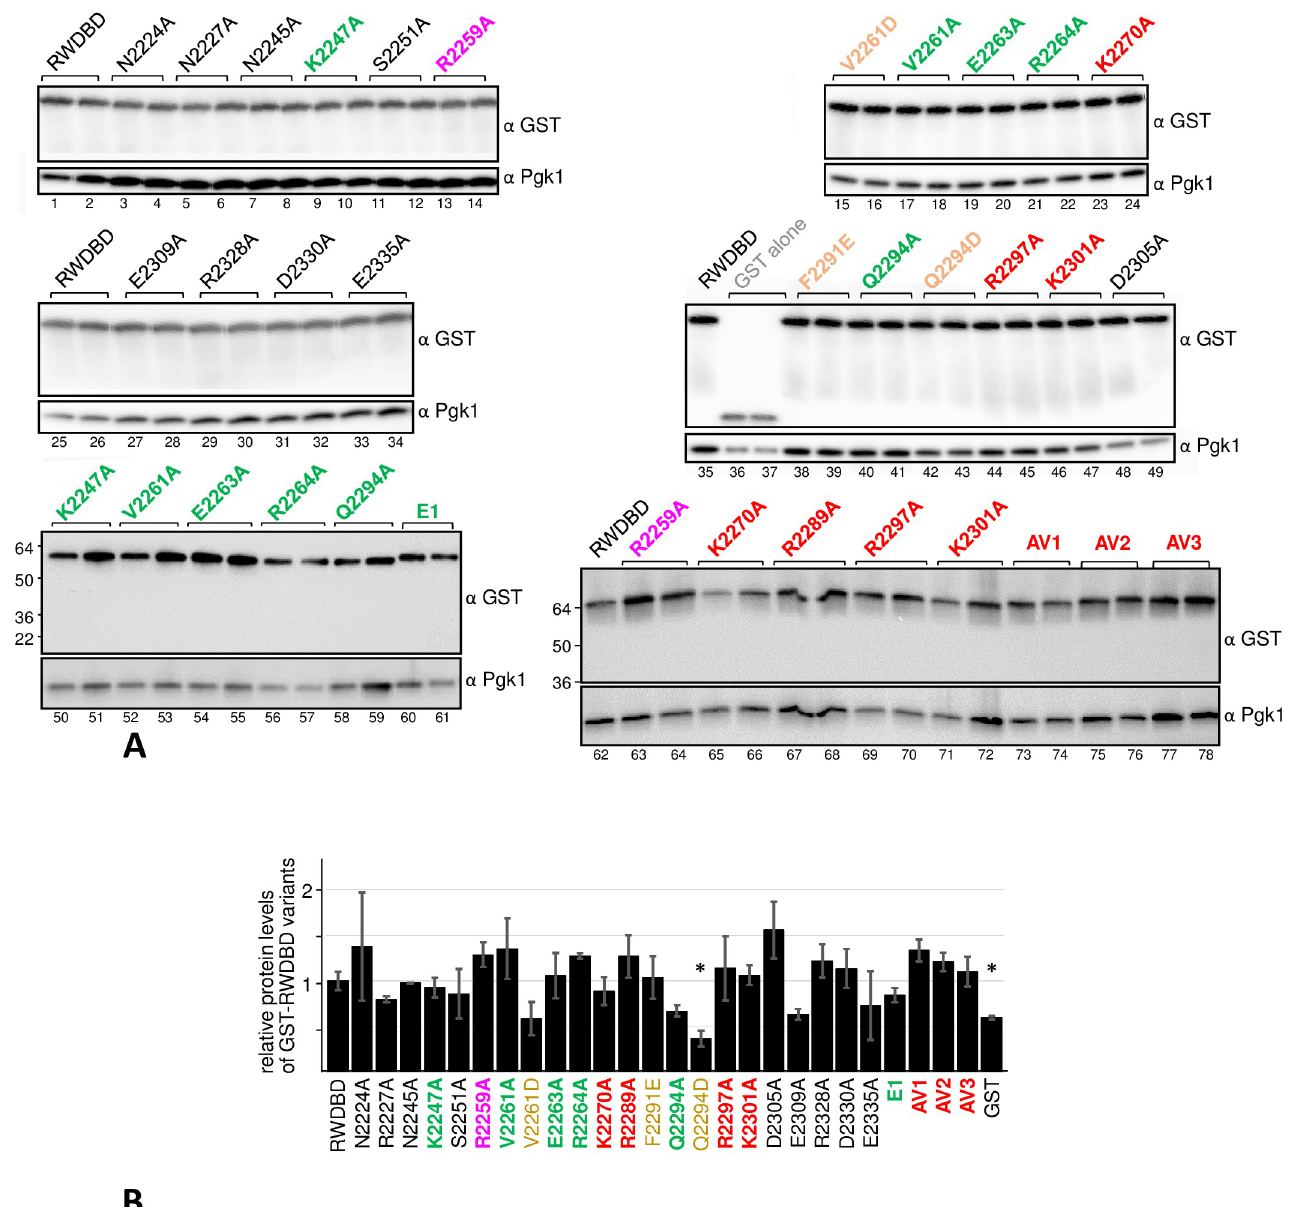
Fig 2. Determining the protein levels of the RWDBD variants. (A) Strains as indicated were grown to exponential phase, exposed to formaldehyde before harvesting, and subjected to western blotting using antibodies against the GST-tag present on all RWDBD variants, and against Pgk1 as control for equal loading. Four independent experiments were conducted and representative images are shown. (B) Signals in (A), obtained from four independent experiments, were quantified using Image J, and for each sample the GST signal was divided by the Pgk1 signal. For each strain, this ratio was divided by the ratio of the strain expressing wild-type RWDBD. These results were plotted in a bar graph, and the standard errors are shown as error bars. Values significantly different to that of RWDBD are indicated with an asterisk (Student two-tailed t-test, p <